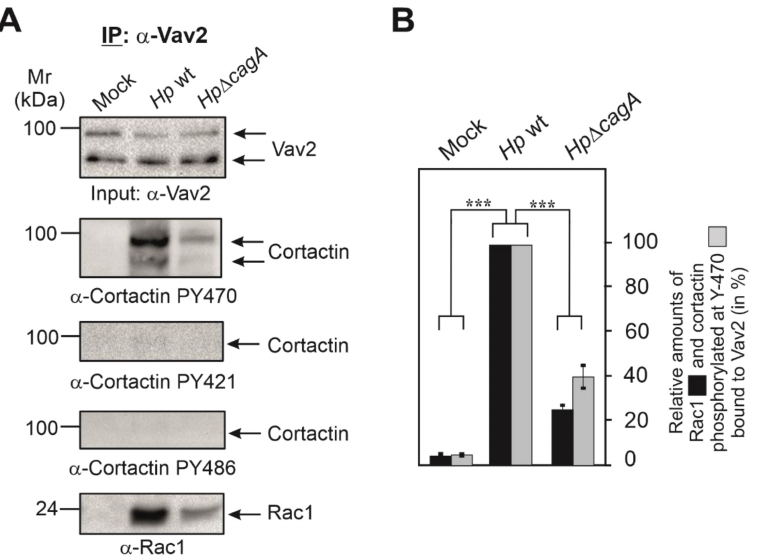
Figure 3. Vav2 forms a physical complex with Rac1 and cortactin phosphorylated at Y-470. ( A ) AGS cells were infected for 6 h with wt H. pylori or ∆ cagA mutant, followed by immunoprecipitation (IP) using Vav2 antibodies. The corresponding Western blots were probed with antibodies as indicated. The results suggest that Vav2 interacts with Rac1 and cortactin phosphorylated at Y-470 in a CagA- dependent fashion. ( B ) Band intensities of Rac1 and phosphorylated cortactin bound to precipitated Vav2 were quantified using the Image Lab Software (Bio-Rad). Error bars represent +/ − SD. p -value of ≤ 0.001 (***) was considered as statistically